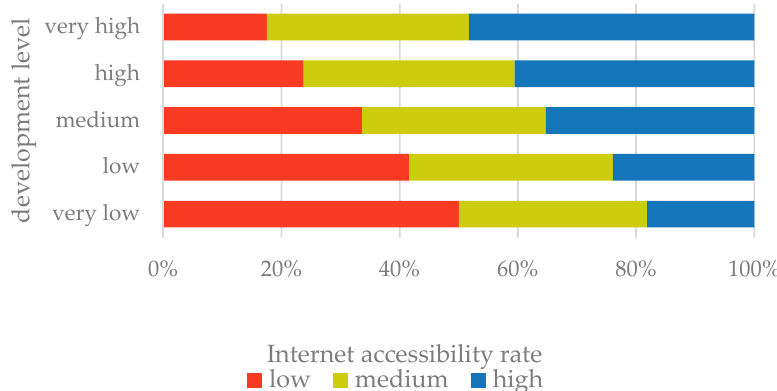
Figure 6. Internet accessibility rate structure according to socio-economic development level. Source: own work.